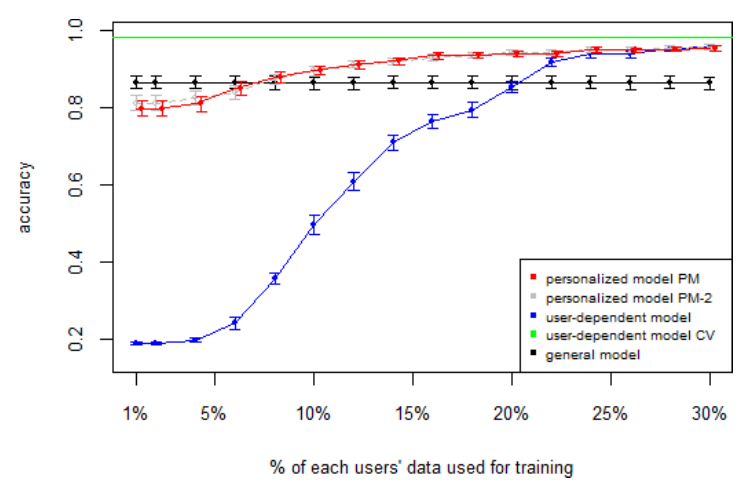
Figure 4. D4: Smartphone dataset. PM: Personalized Model; CV: Cross Validated.